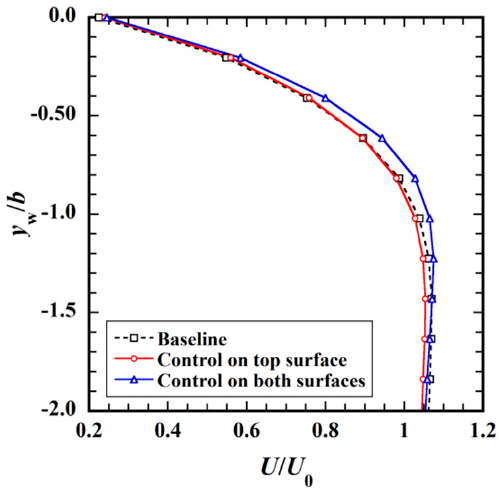
Figure 16. Time-averaged velocity profile at the trailing edge along the vertical position from the bottom surface, y w , during the up-stroke motion.